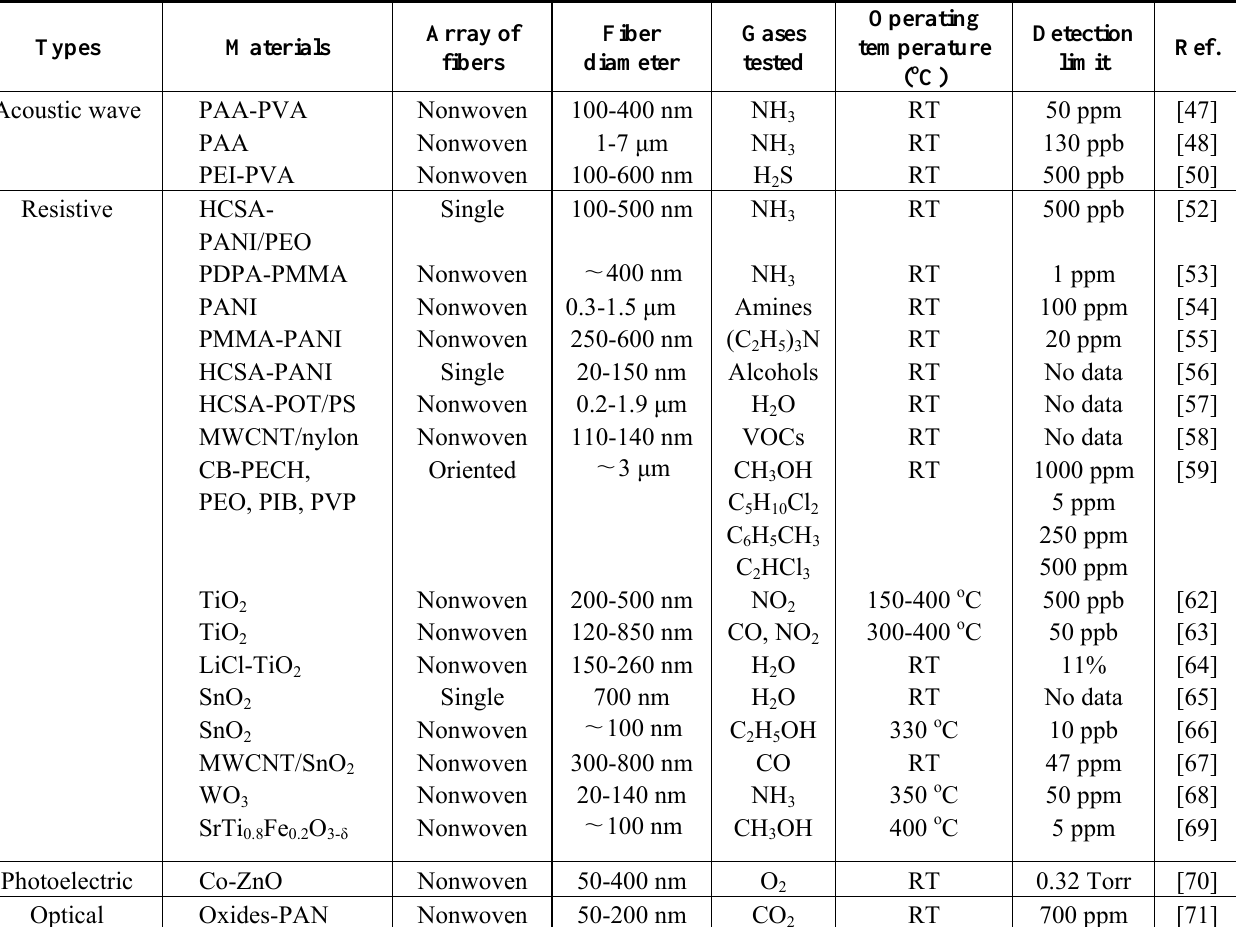
Table 1. Types of electrospun nanofibers based gas